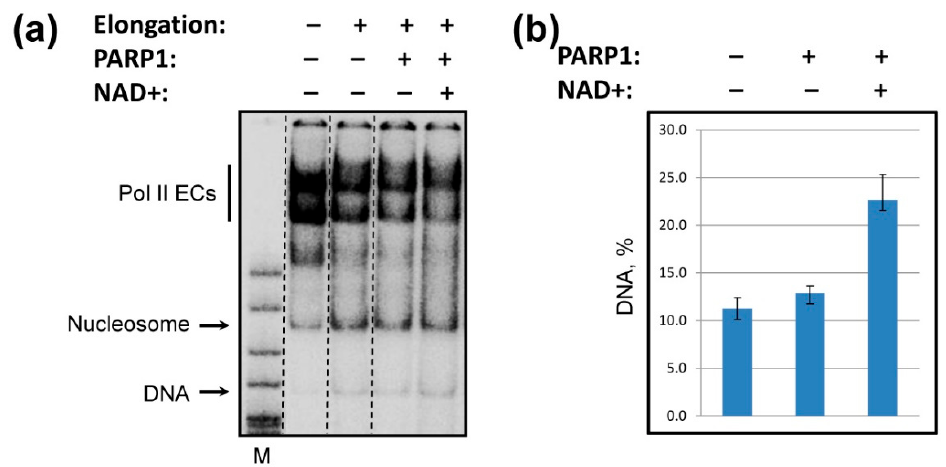
Figure 4. PARP1 facilitates histone eviction during transcription. ( a ) DNA-end-labeled 603 nucleosomes were transcribed in the presence or in the absence of PARP1 and/or NAD+ at 150 mM KCl as described in Figure 1a and analyzed by native PAGE. ( b ) The amounts of histone-free DNA produced after transcription was quantified (presented as a fraction of transcribed templates, see Methods). Averages and standard deviations from three independent experiments are shown. During transcription in the absence of PARP1, a fraction of templates (~10%) lose histone octamer [28] . In the presence of PARP1/NAD+ the amount of histone-free DNA produced during transcription by yPol II is considerably increased.